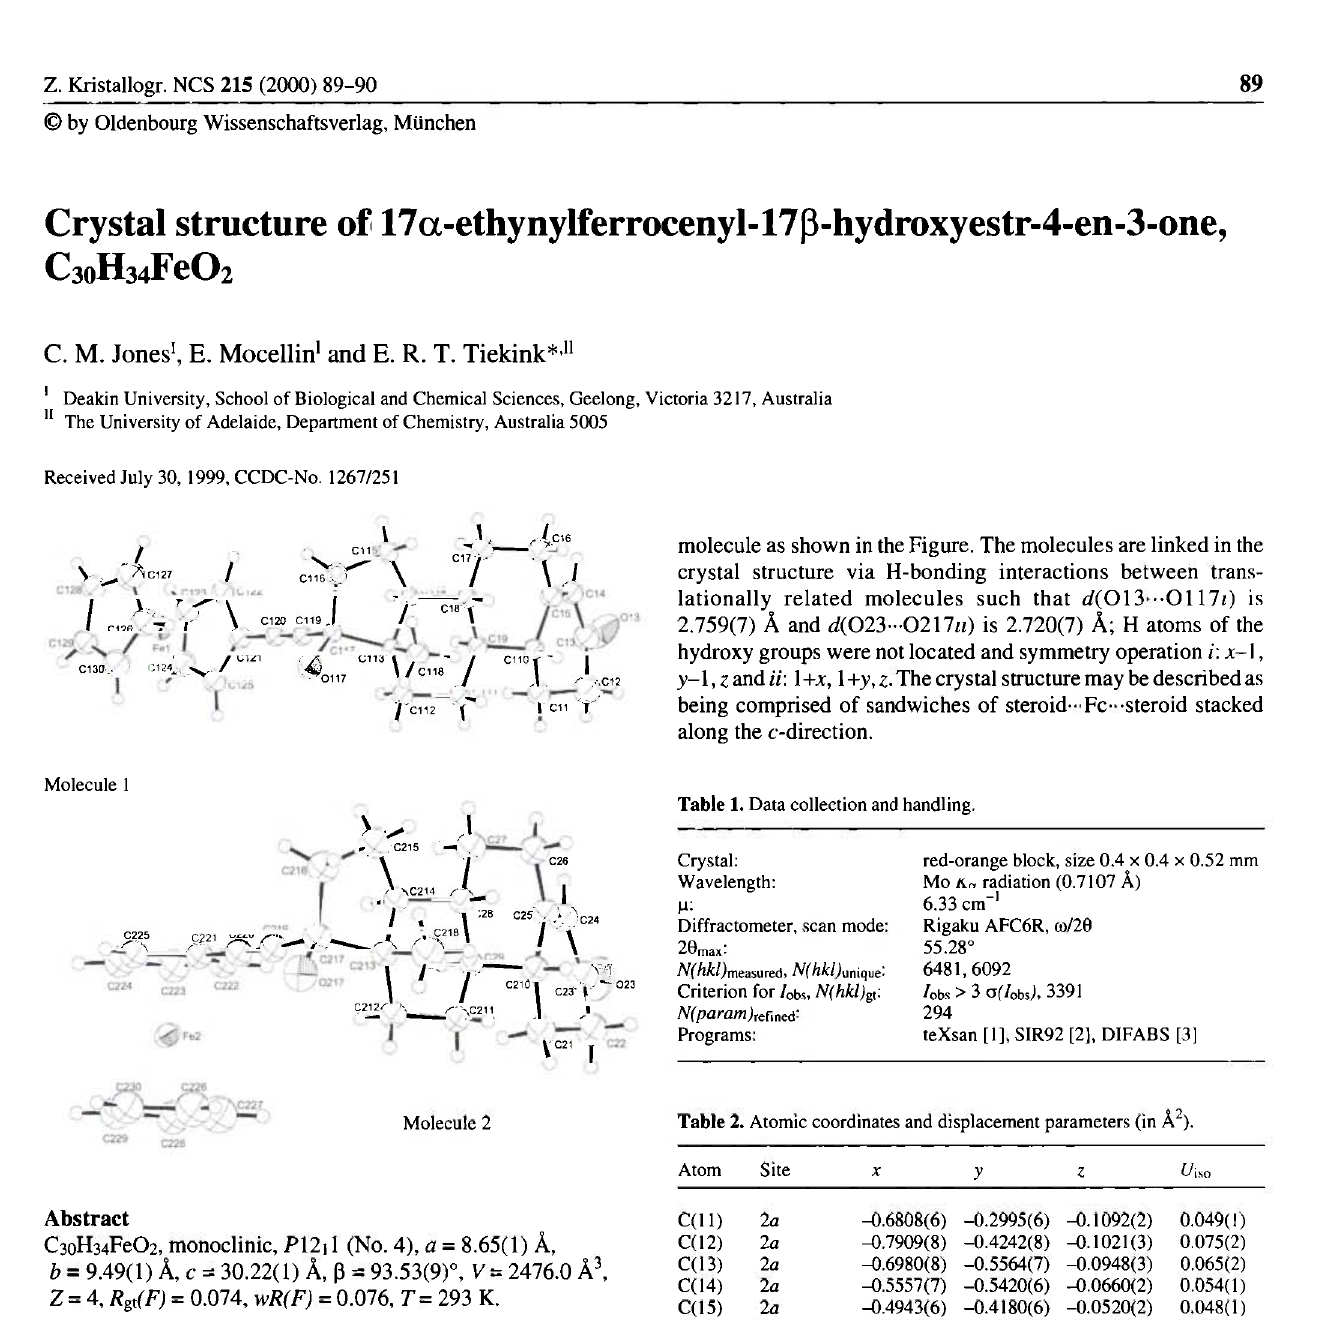
Table 2. Atomic coordinates and displacement parameters (in Ä 2